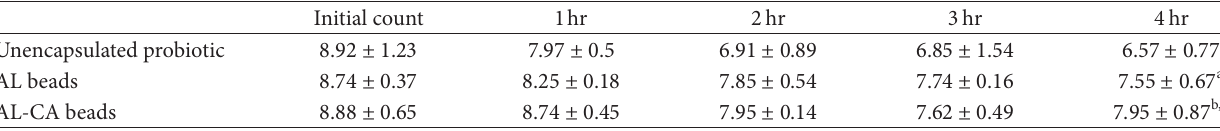
All values are represented as mean ± standard deviation in. a 𝑃 < 0.05 versus unencapsulated probiotic; b 𝑃 < 0.05 versus unencapsulated probiotic; c 𝑃 < 0.05 versus AL beads after 4 hours of incubation in 0.3% bile salts.